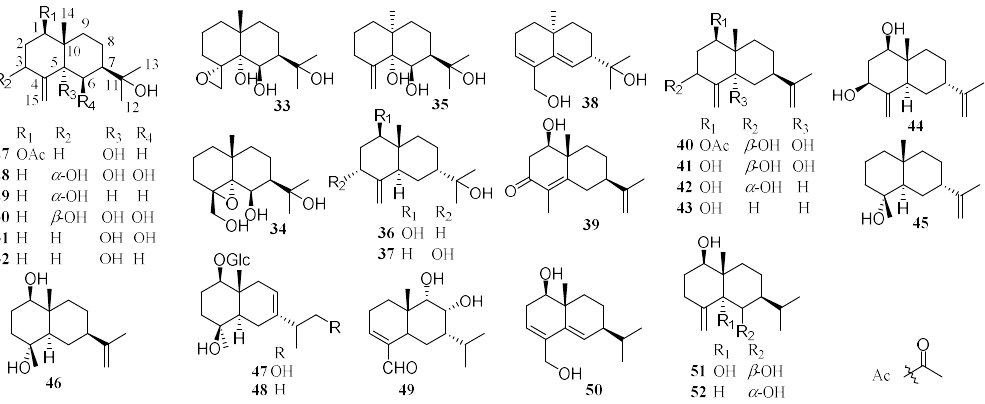
Figure 2. Eudesmane-type sesquiterpenoids from Chrysanthemum genus.